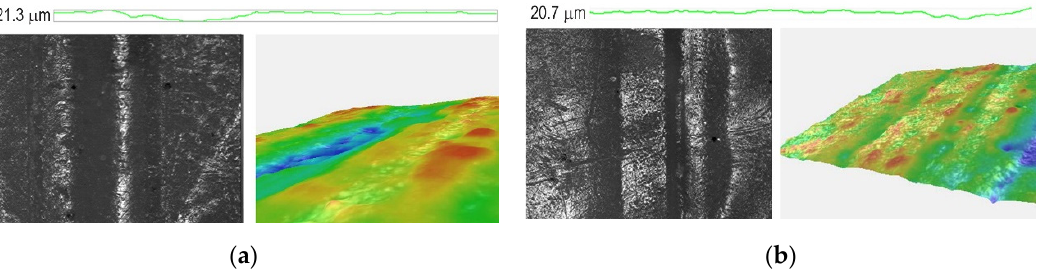
Figure 12. 2D and 3D images and a profile of the PCL/PLA/CF blends: ( a ) 100/0/3 and ( b ) 80/20/3 (magnification 40×).